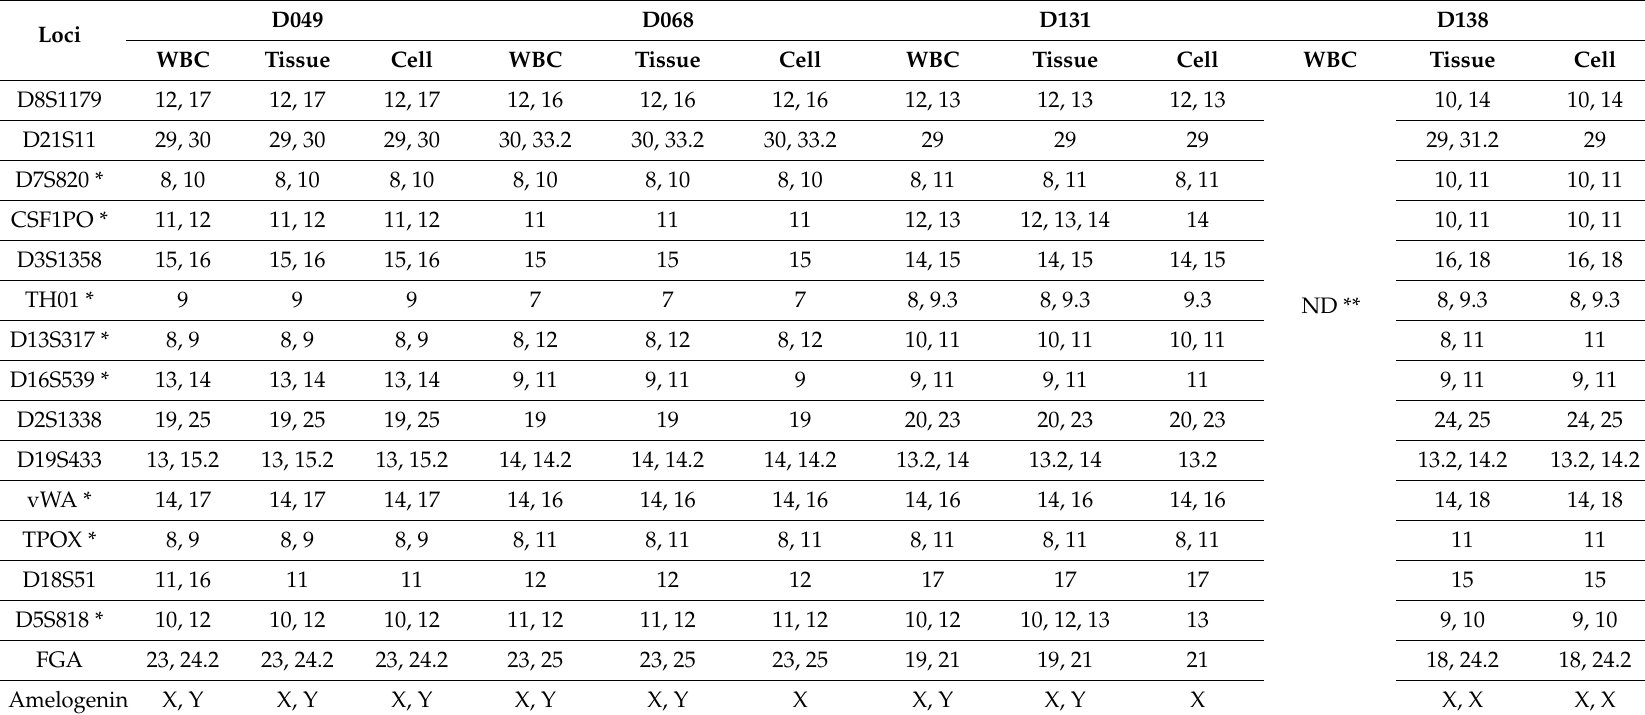
Table 2. Comparison of STR profiles of CCA tissues, patient WBC, and newly established cell